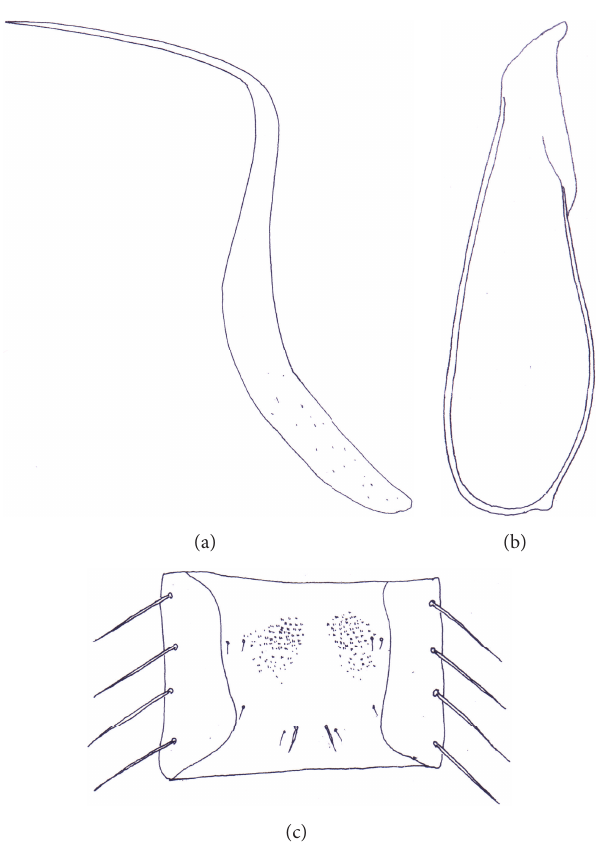
Figure 7: Rheotanytarsus caputimberus n. sp., pupa: (a) thoracic horn; (b) wing sheath; and (c) tergite